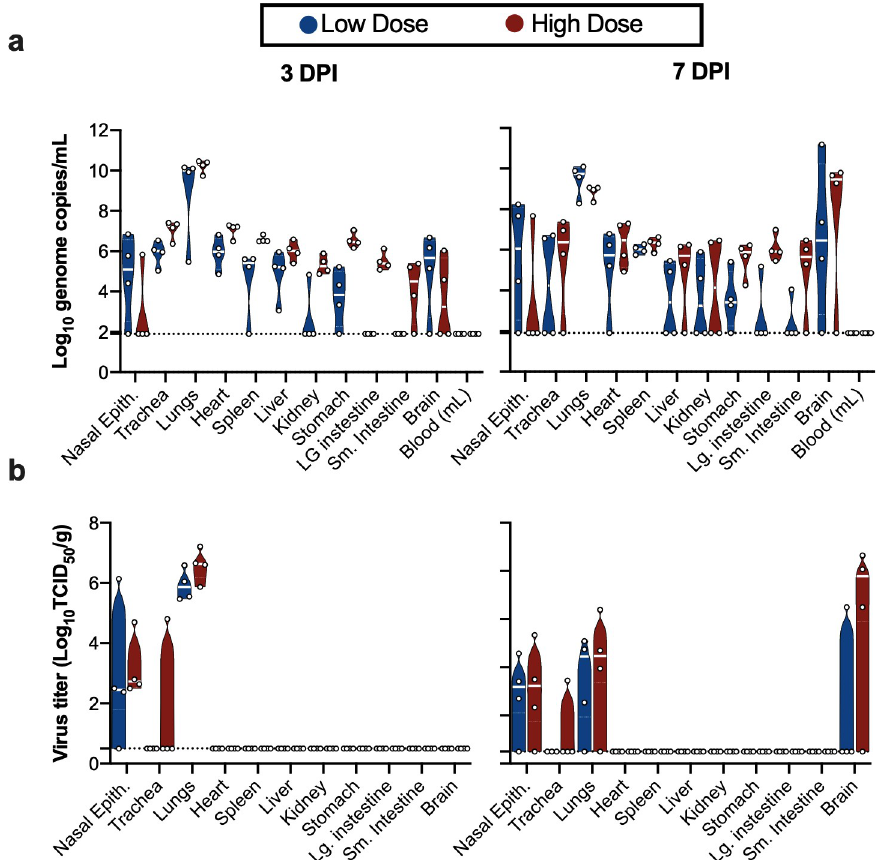
Fig 2. SARS-CoV-2 tissue tropism in K18-hACE mice. a. Violin plot of viral load in tissues quantified by RT-qPCR with median as centre. b. Violin plot of infectious SARS-CoV-2 titers in tissues, with median as centre. Blue: 10 4 TCID 50 (low dose animals, n = 6); red: 10 5 TCID 50 (high dose animals, n = 6); green: 10 5 TCID 50 γ -irradiated (control animals, n = 2); dotted line = limit of detection.